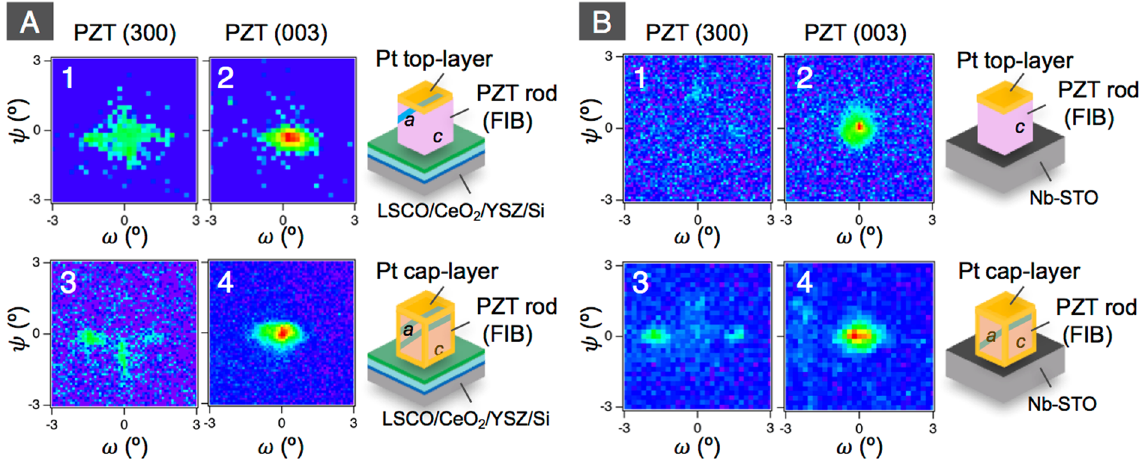
Figure 5. XRD ω - ψ maps for PZT (300) and (003) of 1 μ m-wide PZT rods on LSCO/CeO 2 /YSZ-buffered on Si(100) ( A ) and Nb-STO (100) ( B ). 1 and 2: rod with top Pt-surface, and 3 and 4: rod covered with Pt on both top and sidewall surfaces.